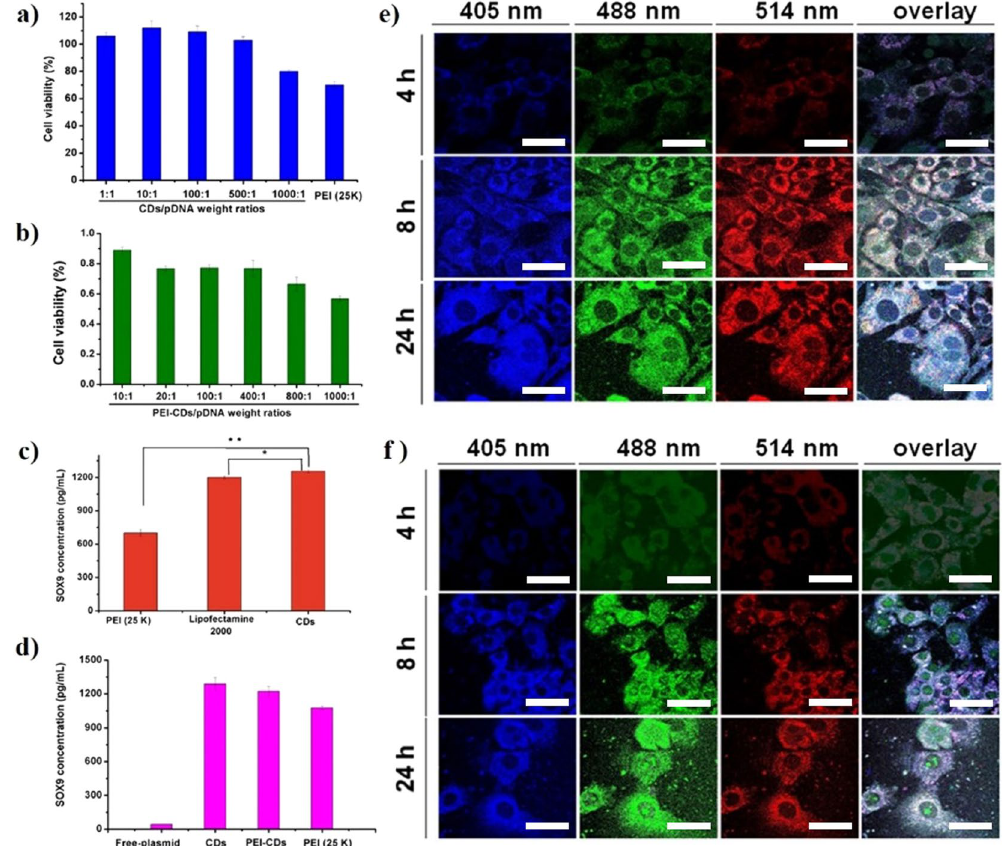
Figure 2. Cytotoxicity assay and transfection efficiency. ( a ) Cytotoxicity of CDs/pDNA nanoparticles formed at various ratios (1:1, 10:1, 100:1, 500:1, and 1000:1) compared with PEI (25 kDa) ( ** P < 0.01); ( b ) Cytotoxicity of PEI-CDs/pDNA complexes formed at various ratios (10:1, 20:1, 100:1, 400:1, 800:1, and 1000:1); ( c ) In vitro gene transfection efficiency of CDs/pDNA nanoparticles compared with PEI (25 kDa)/pDNA and Lipofectamine 2000/pDNA ( * P < 0.05; ** P < 0.01); ( d ) Comparison of the transfection efficiency among CDs/ pDNA nanoparticles, PEI-CDs/pDNA complexes, PEI (25 kDa)/pDNA and free plasmid DNA; ( e ) Real-time imaging of CDs/pDNA complexes following transfection of UCDSCs. Similar conditions were applied in this case; ( f ) Real-time imaging of CDs/pDNA complexes with YOYO-1-labeled DNA following transfection of MEFs. The 405, 488 and 514 nm cell columns were observed 4, 8, and 24 h after transfection. Scare bars = 5 μ m. Values are the means ± SD of three repeated